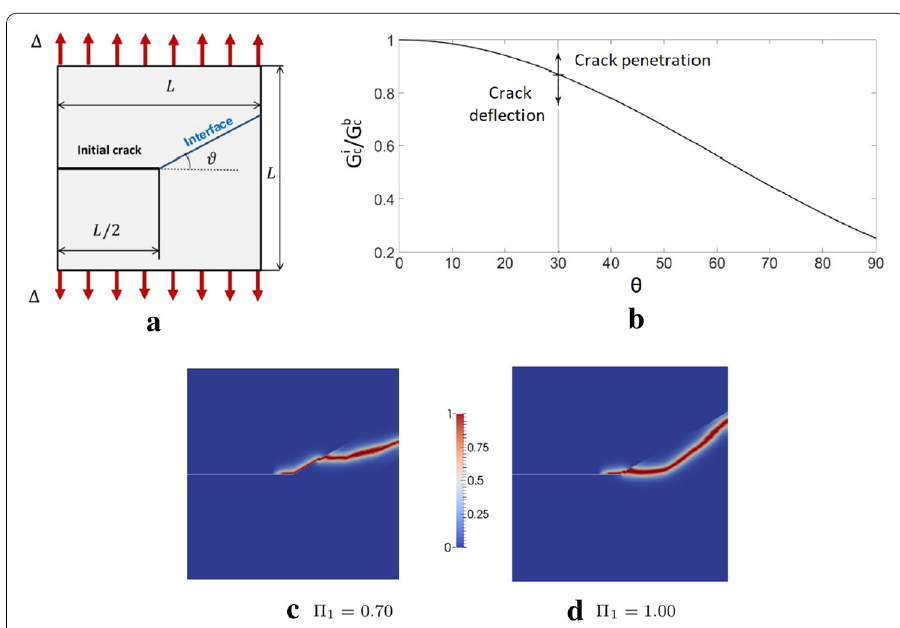
Fig. 8 a Geometry considered to study the effect of a crack impinging on an interface; b curve which separate the crack penetration and deflection cases for different impinging angles; transition from crack deflection, c to crack penetration, d for a brittle interface ( (cid:4) 2 → 0) with angle θ = 30 ◦ (from